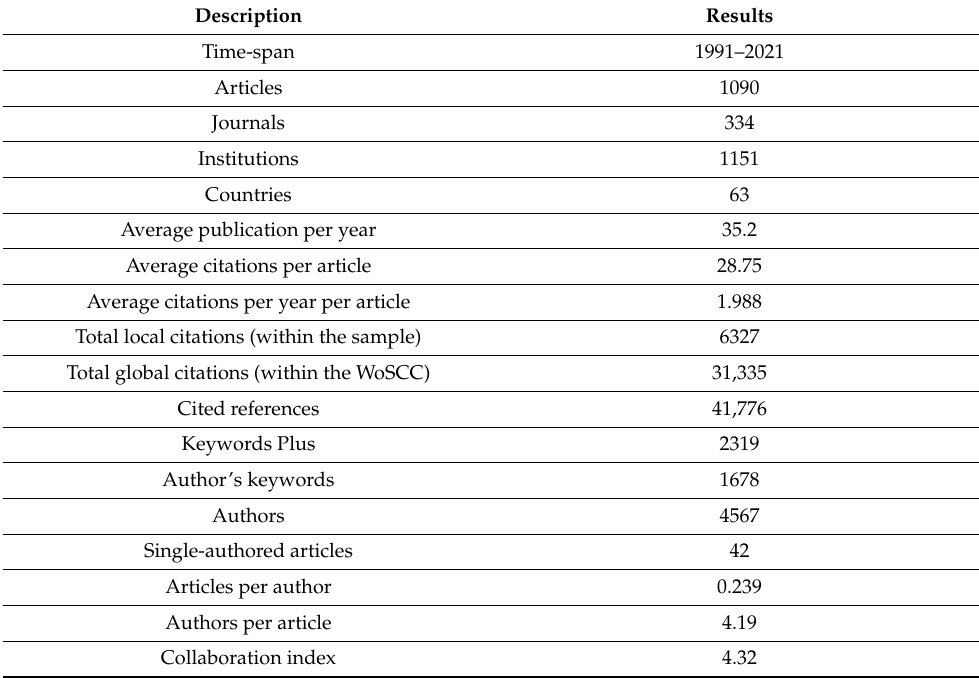
Figure 1. Articles selection flow chart. Table 1. Main description of the included